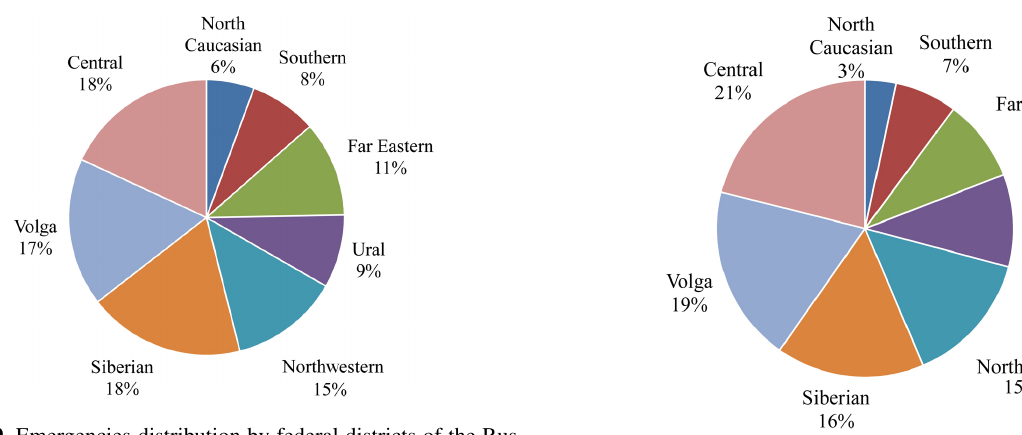
Figure 11. Distribution of technological emergencies by federal districts of the Russian Federation.